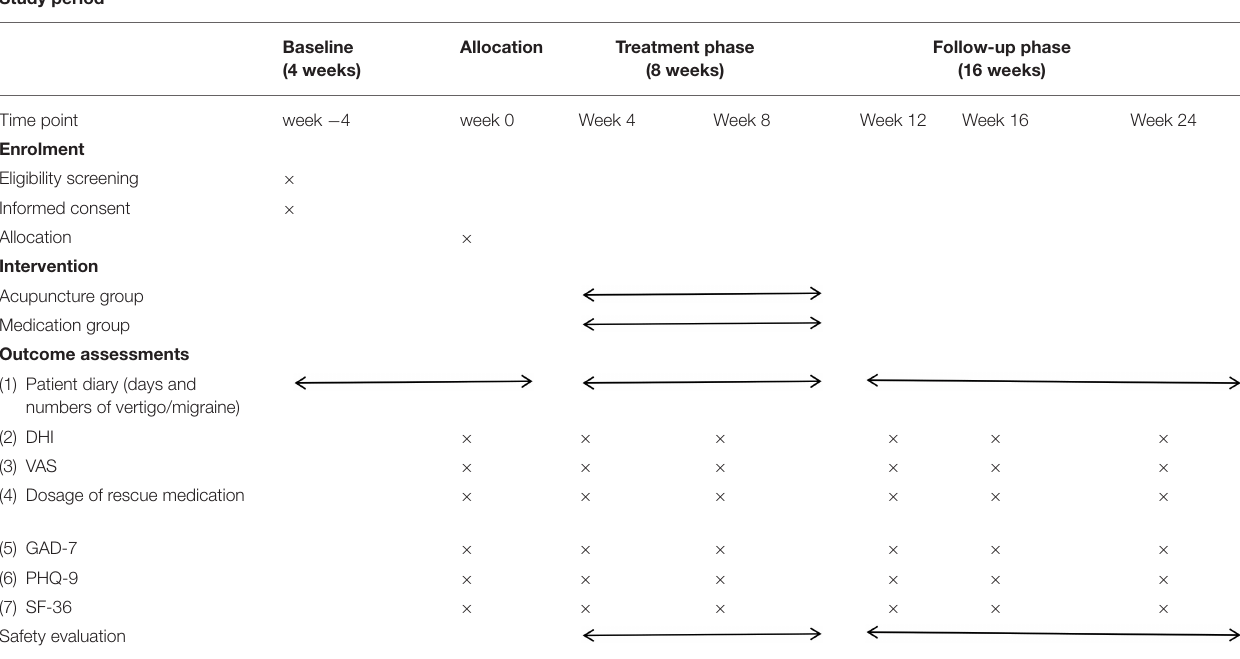
TABLE 1 | Schedule of enrolment, interventions, and outcome assessments. Study